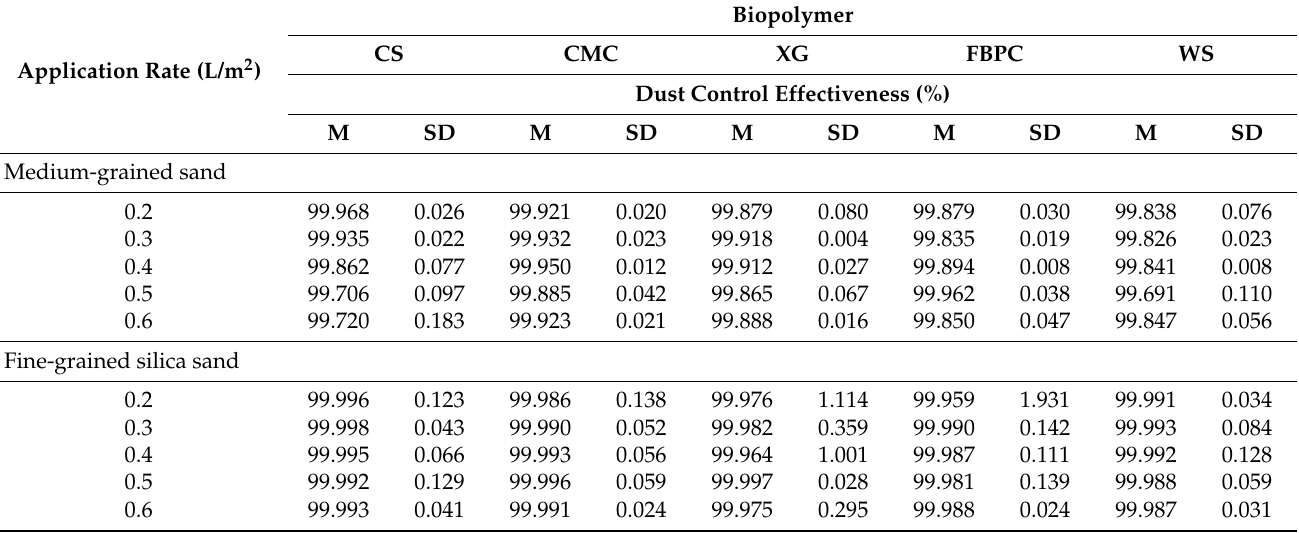
Table A3. Dust control effectiveness for different application rates on medium-grained sand and fine-grained silica sand in relation to the untreated control group.